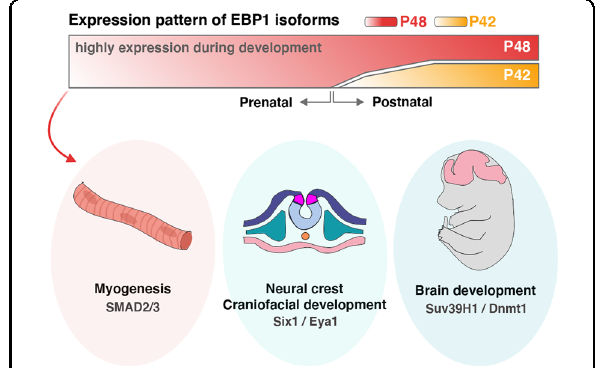
Fig. 4 Roles of EBP1 isoforms in development. The two isoforms of EBP1 have a different expression patterns. During development, p48 is highly expressed as a major isoform contributing to myogenesis, neural crest and craniofacial development and brain development. p42, however, is expressed after the postnatal period, and its role in development has not yet been